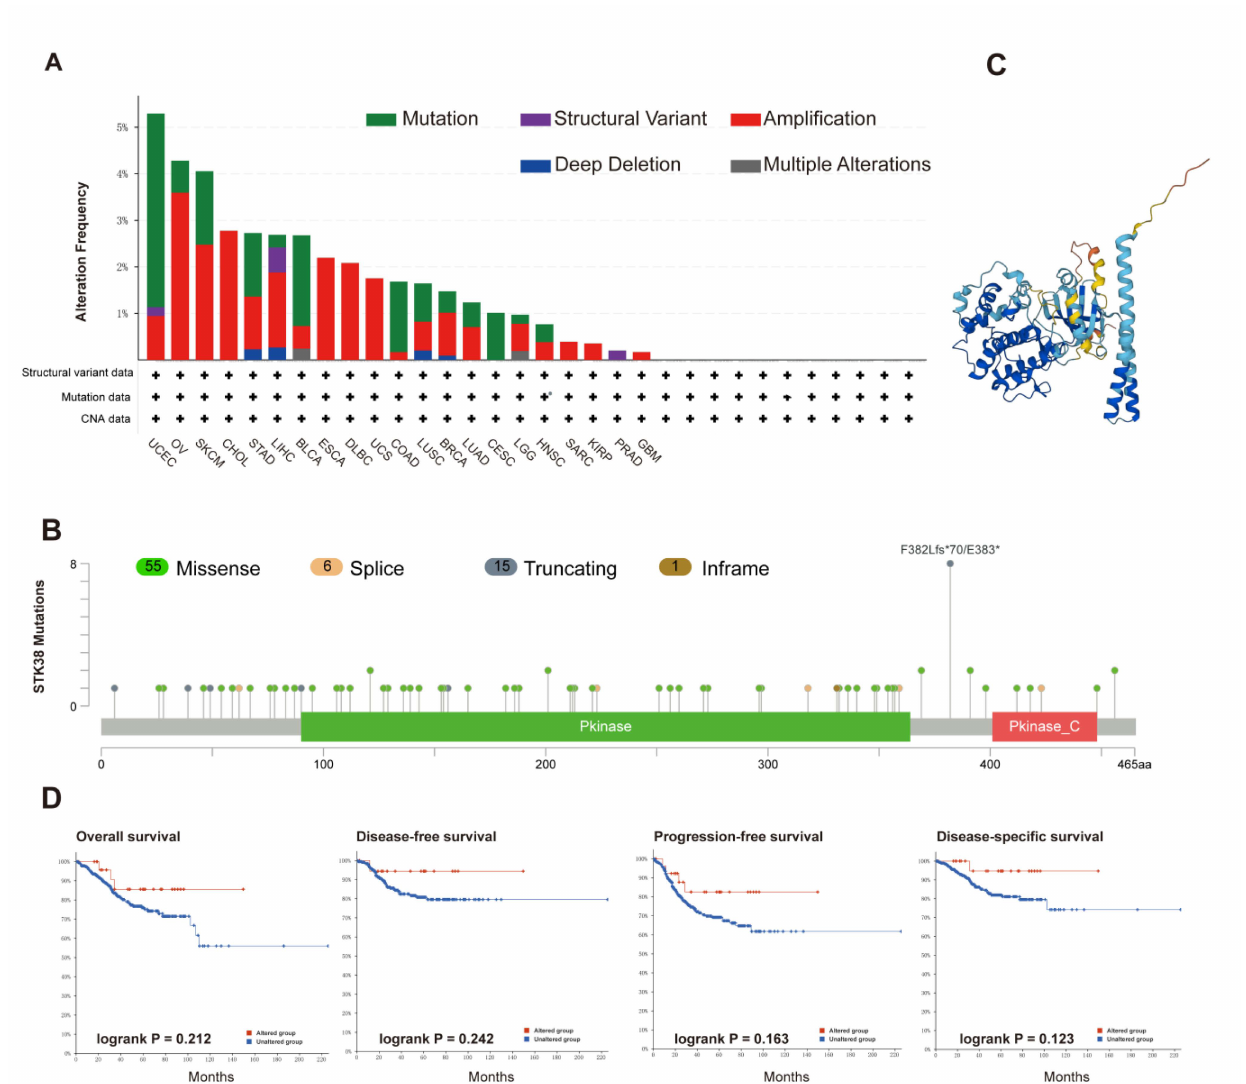
Figure 4. Alteration characterizes of STK38 in TCGA tumors. The mutation features of STK38 were analyzed using the cBioPortal tool. The alteration frequency with mutation type ( A ) and mutation site ( B ) are shown. ( C ) Protein structure of STK38. ( D ) Correlation analysis of STK38 between mutation status and overall, disease-specific, disease-free and progression-free survival using the cBioPortal tool. The red lines represent the altered groups, and the blue lines represent the unaltered